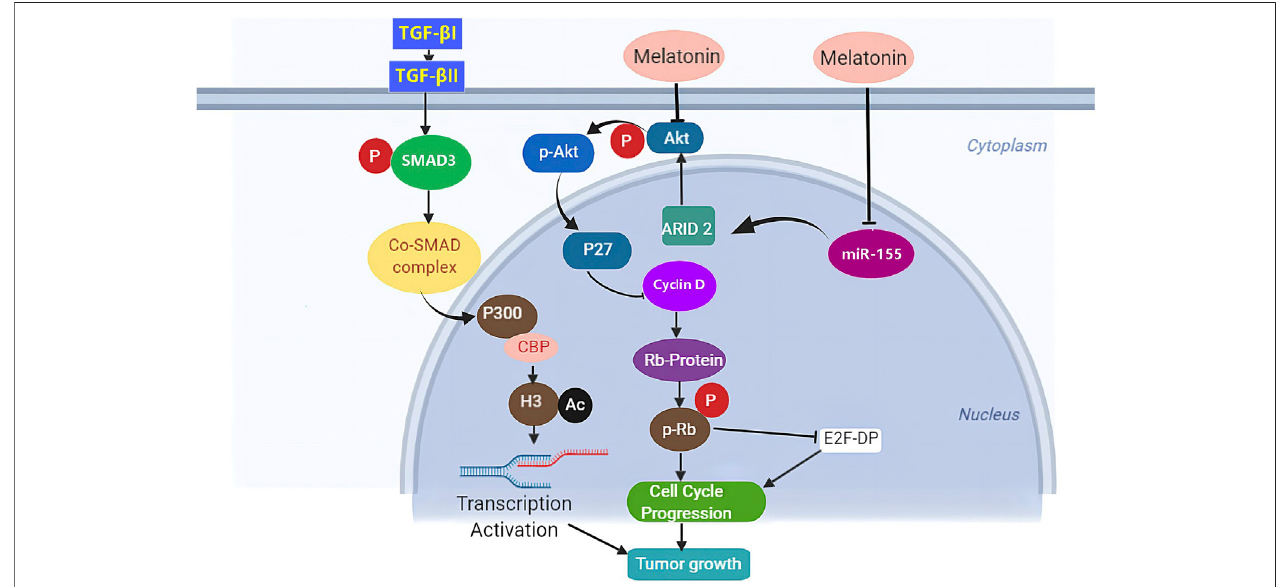
FIGURE. 3 | The proposed mechanism underlying the anti-tumor effects of melatonin. Melatonin arrests cell cycle progression through downregulation of phosphorylated protein kinase B (p-Akt) dependent